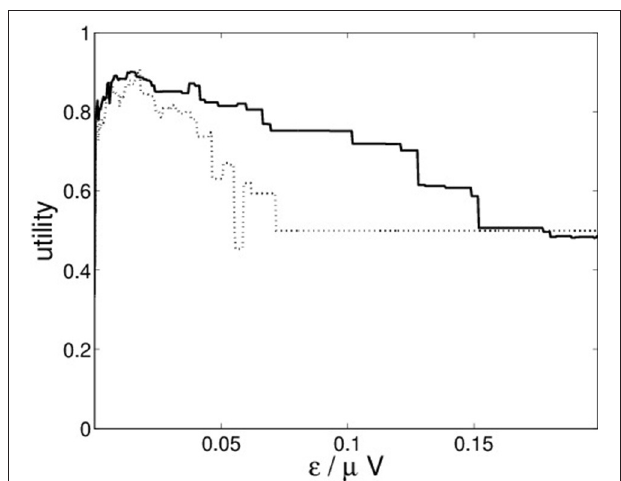
FIGURE 4 | RSA Markov utility functions for conditions (22-a) (solid) and (22-b) (dotted).